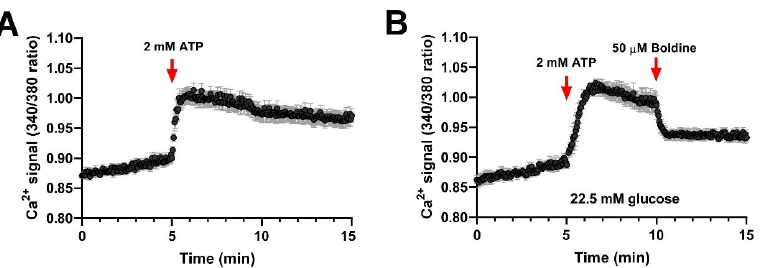
Figure 4. Boldine blocks P2X 7 receptors of cells cultured in high glucose. Hela cells were transiently transfected with a P2X 7 R-EGFP vector in 22.5 mM glucose and 24 h after being loaded with Fura-2 to evaluate the P2X 7 R activity in response to boldine. ( A ) Treatment with 2 mM ATP evoked a rapid and significant increase in Ca 2+ signal and showed a nadir for at least 10 min. ( B ). When 50 µM boldine was applied after 5 min of ATP stimulation, the Ca 2+ signal decreased drastically. Each plotted point corresponds to the average ± SEM of the Ca 2+ signal. In each experiment, ~20 EGFP-positive cells were recorded over time (n = 3).